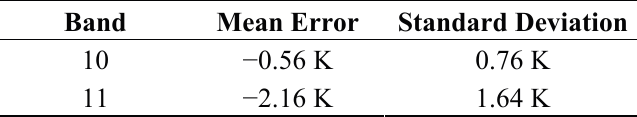
Table 3. Summary of results for Landsat